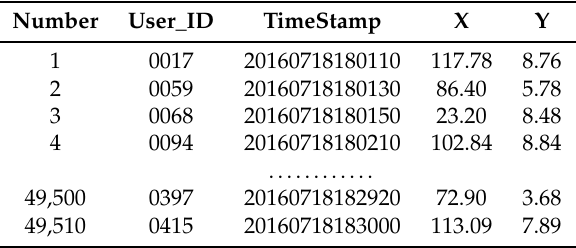
Table 4. Format of pre-processed WiFi positioning